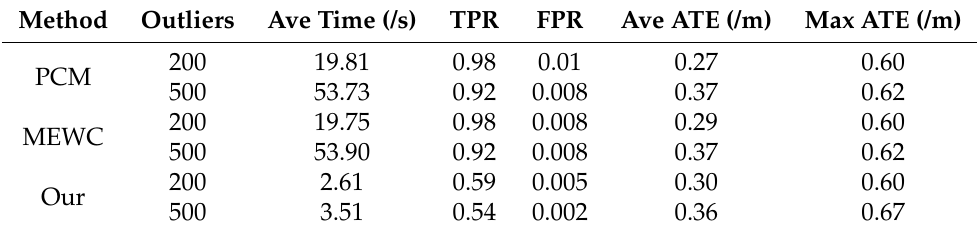
Table 2. Simulation Results: